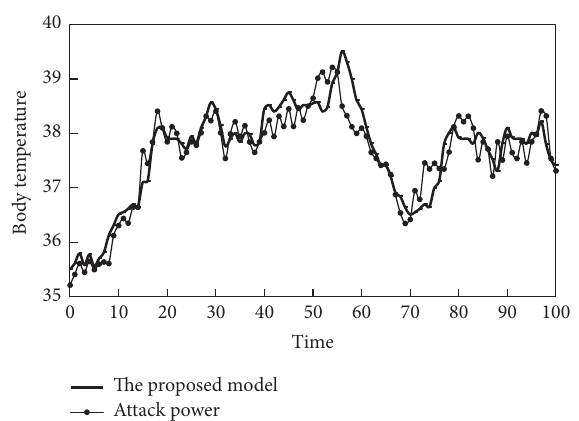
Figure 12: The change curve of the measured body temperature and the actual attack intensity with the proposed